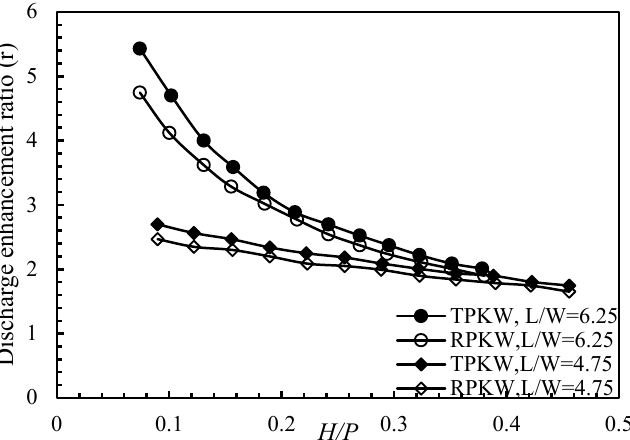
Figure 9. Variation of r with H/P ratio; TPKW: Trapezoidal piano key weirs and RPKW: Rectangular piano key weirs.